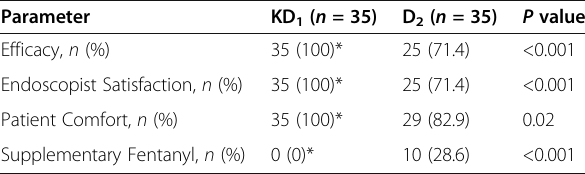
Table 2 Comparison of induction, procedure, and recovery times in the two studied groups Parameters